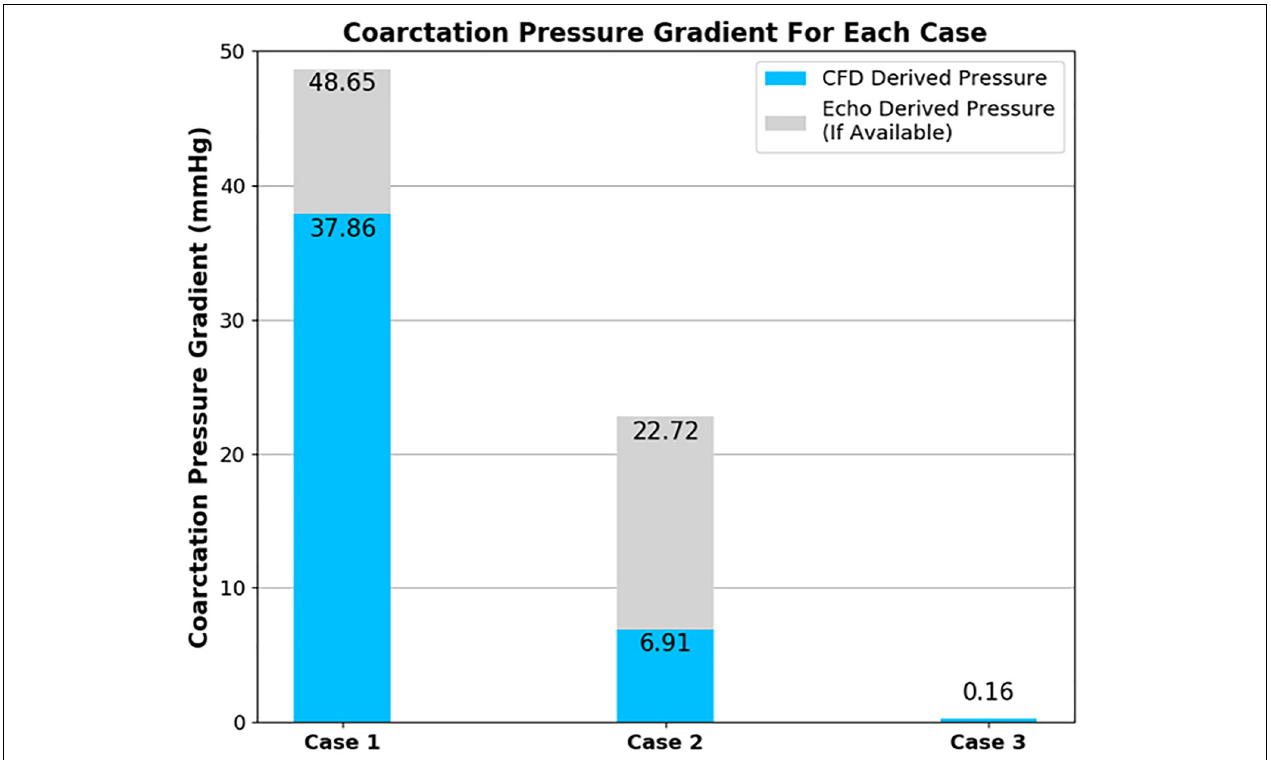
FIGURE 9 | Plot showing the pressure difference across the coarctation derived from CFD in comparison to echocardiography measurements for each case of coarctation repair. Note that echocardiography data was not available for case 3.